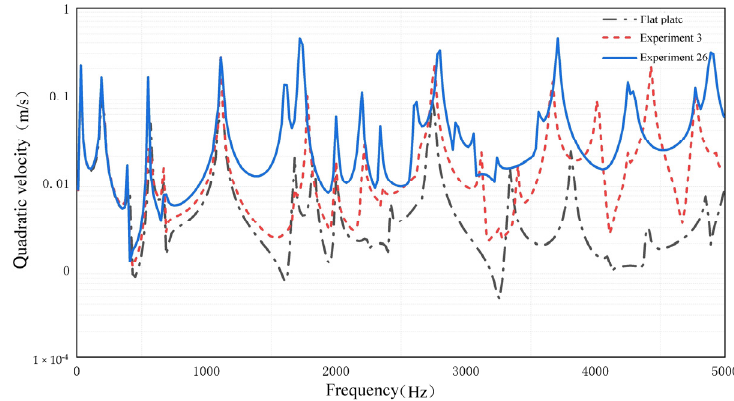
Figure 12. The Quadratic velocity of three experiments.